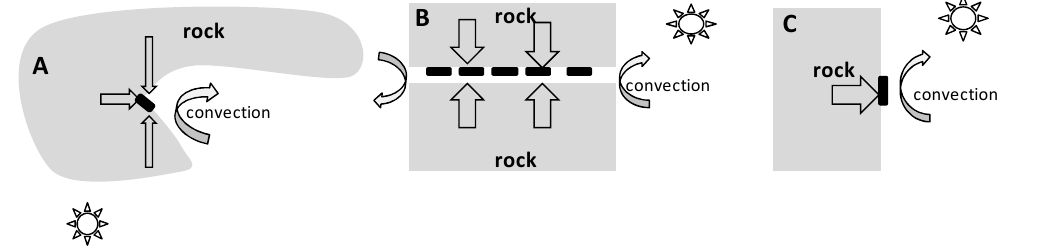
Figure 7. Cross-sectional diagrams of microhabitats. ( A ) is a recess in the rock, triangular in section (“recess”); ( B ) is a slit through the rock (“slit”); ( C ) is a flat rock surface (“flat surface”). The black rectangles indicate the locations of egg masses on the surface of the rock. The straight arrows indicate the heat flow vectors from the inside of the rock to its surface. The curved arrows indicate the influence of air flows. The sun shows the source of solar radiation.